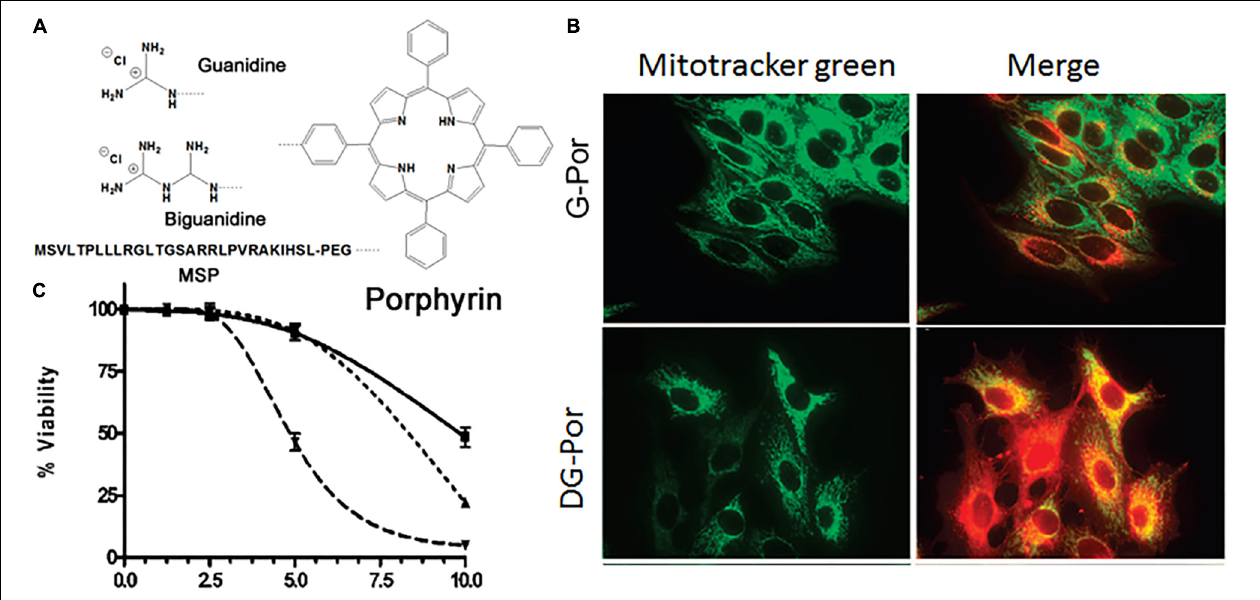
FIGURE 4 | (A) Chemical structures of guanidine-porphyrin (G-Por), diguanidine-porphyrin (DG-Por), and peptide-porphyrin conjugates; (B) mitochondrial localization of G-Por and DG-Por in HepG2 cell at 24 h (green for MitoTracker R (cid:13) green and red for porphyrin); (C) phototoxicity of G-Por (dashed line), DG-Por (dotted line), and peptide-Por (continuous line) toward HepG2 cells using a 1 J/cm 2 dose of light. Images (B,C) were adapted with permission from reference (Sibrian-Vazquez et al.,